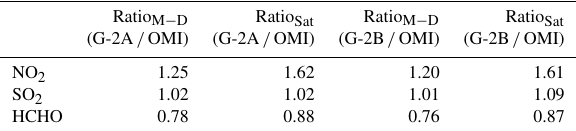
Table 1. Mean ratios for the data presented in Fig.